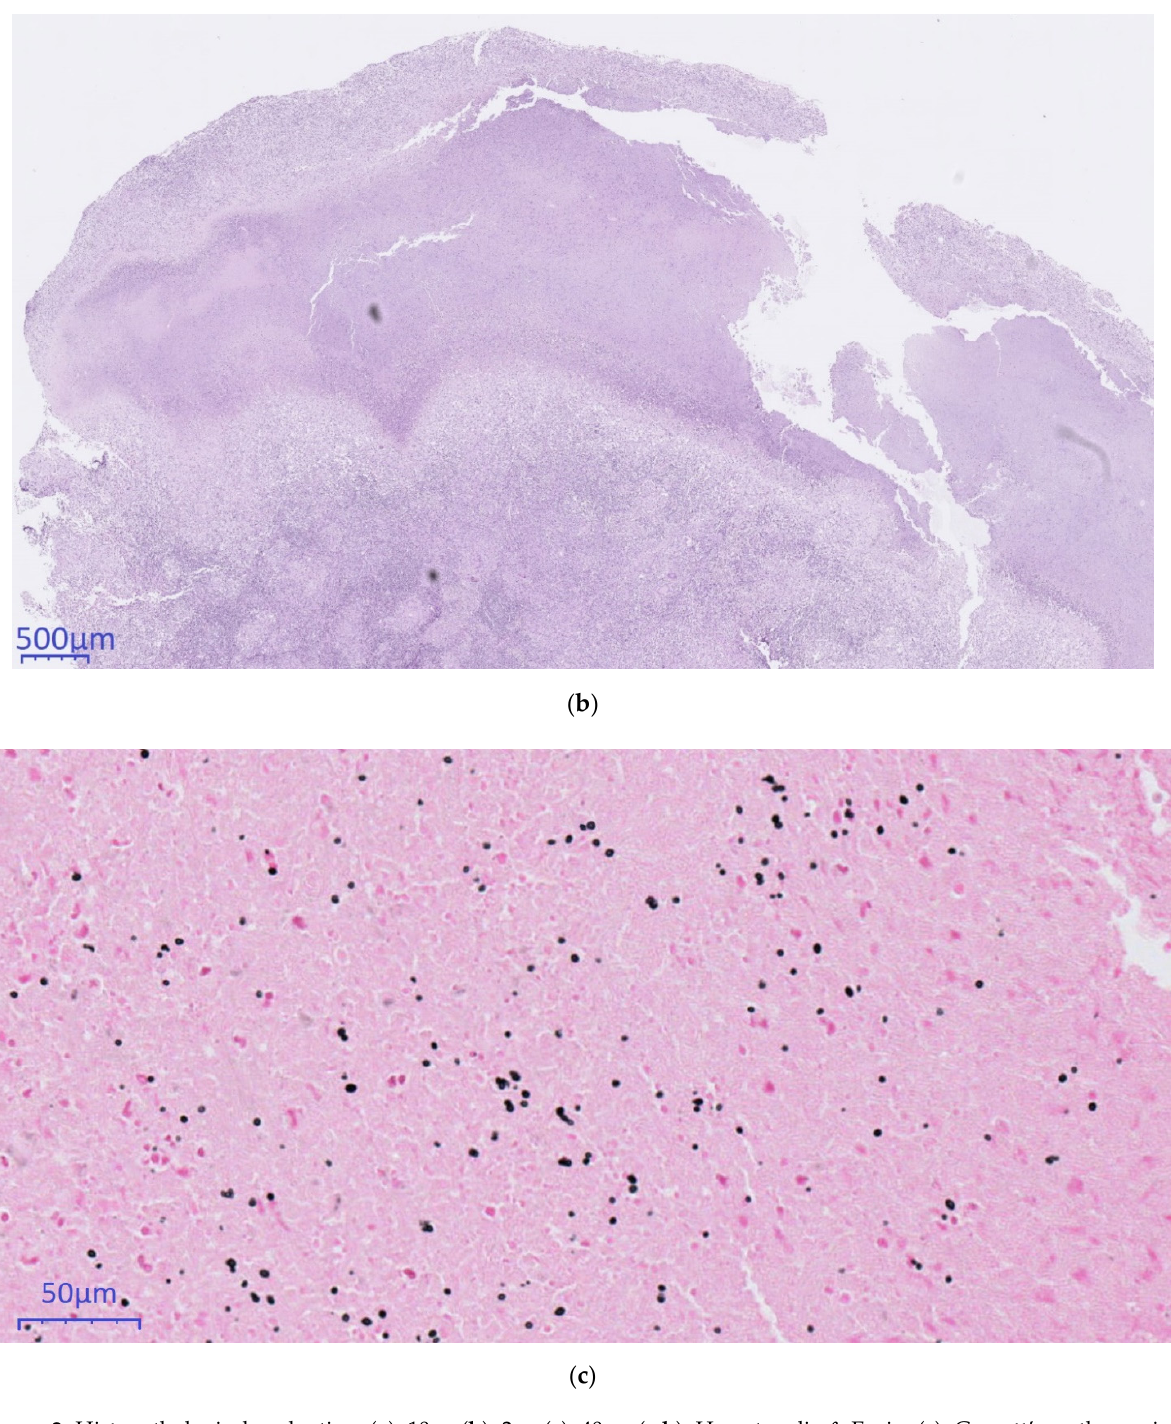
Figure 2. Histopathological evaluation. ( a ): 10 × . ( b ): 2 × . ( c ): 40 × ., ( a , b ): Hematoxylin & Eosin. ( c ): Grocott’s methenamine silver stain. ( a ) CT-guided core needle biopsy of the pulmonary mass showing organizing pneumonia ( b ) Supraclavicular lymph-node presenting with necrotizing granulomas ( c ) Typical ovoid Histoplasma capsulatum yeasts stained in black and thus made visible using Grocott’s methenamine silver staining.